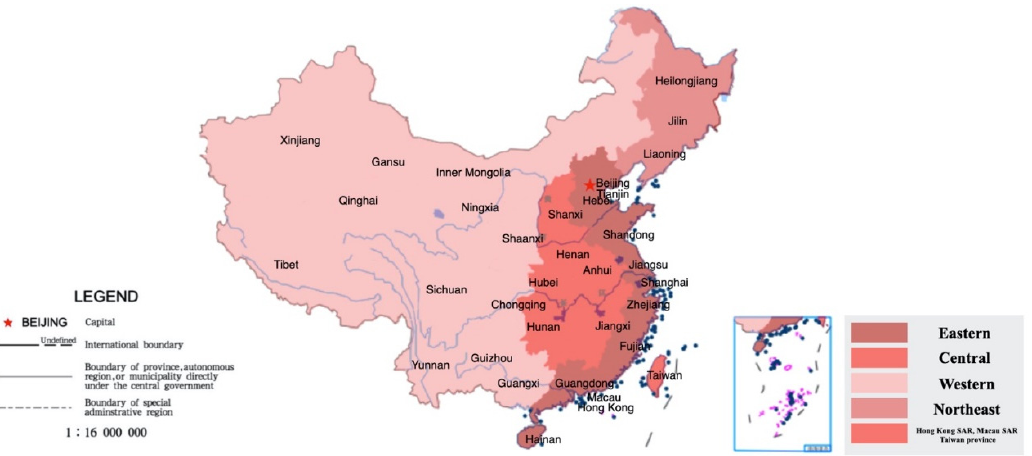
Figure 1. Regional divisions of Eastern, Central, Western, and Northeastern China (The map of China was generated by the standard map online service; URL link: http://bzdt.ch.mnr.gov.cn (accessed on 7 May 2022)).